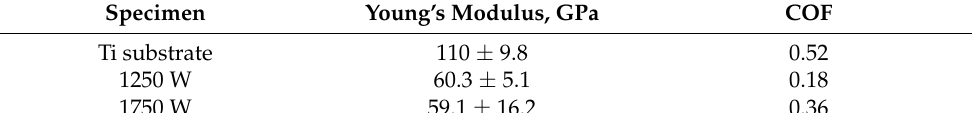
Table 2. Young’s modulus and coefficient of friction of the Ti substrate and Ti–Ta surface alloys formed by a beam power of 1250 and 1750 W.